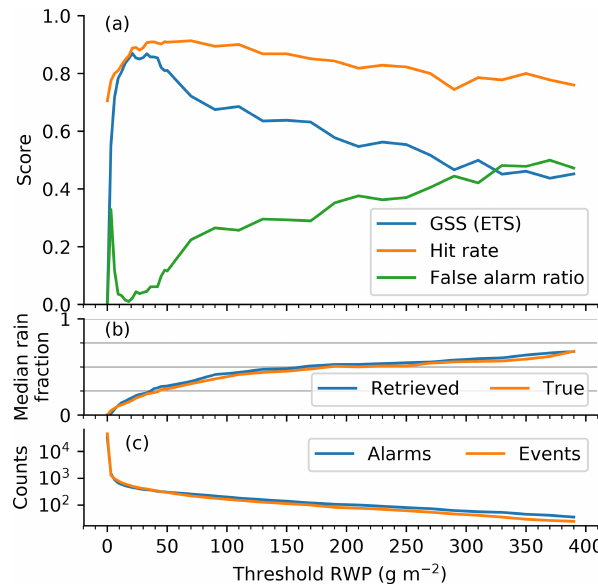
Figure 9. Scores for detecting an atmospheric profile with RWP higher than the respective threshold. (a) Gilbert skill score (GSS), hit rate, and false alarm ratio. (b) Median fraction of rainwater as a function of RWP threshold. (c) Number of alarms and events for retrieved and true RWP above the threshold,